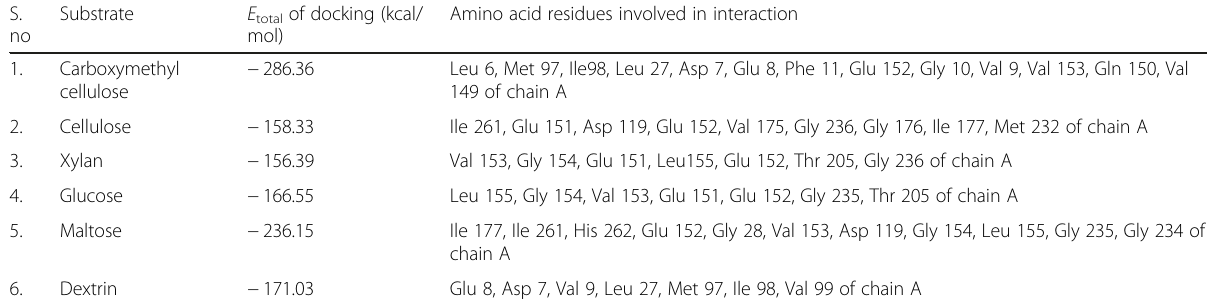
Table 2 Binding energies ( E total ) for the interaction of carboxymethyl cellulose, cellulose, xylan, glucose, maltose, and dextrin with PW1 endoglucanase and the sites of interaction on the enzyme S. Substrate E total of docking (kcal/ Amino acid residues involved in interaction no mol)